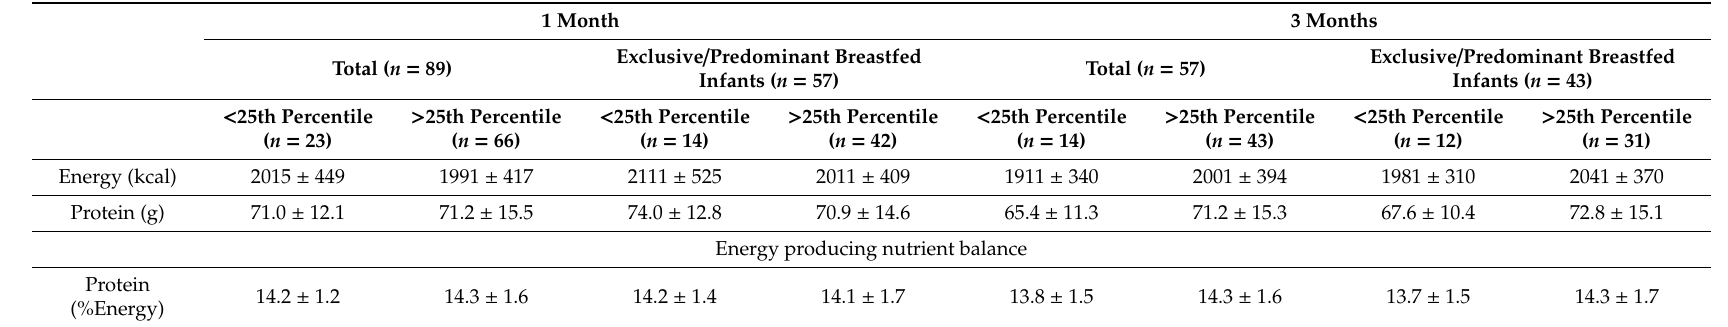
Table 3. Maternal energy and protein intakes according to infant weight above and below the 25th percentile at 1 and 3 months after birth.